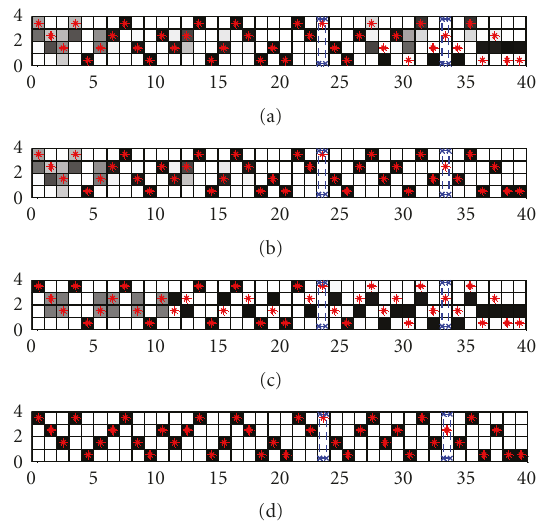
Figure 6: Marginal distribution of labeling variable in exact inference. The 24th and 34th observations are missed, depicted as dashed column. The true labels are depicted by stars. Each column represents the marginal distribution of the label of an observation. Grayscale corresponds to probability value. Black represents probability 1 and white probability 0. (a) Forward pass with 0-order model. (b) Forward pass with 1-order model. (c) Backward pass with 0-order model. (d) Backward pass with 1-order model.